Question: In one sentence, what is this figure communicating?
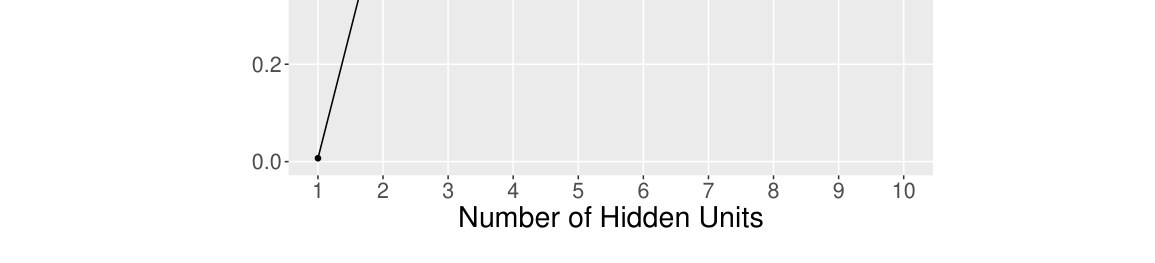
Answer: Number of hidden nodes versus the probability of selecting the correct input- layer structure.